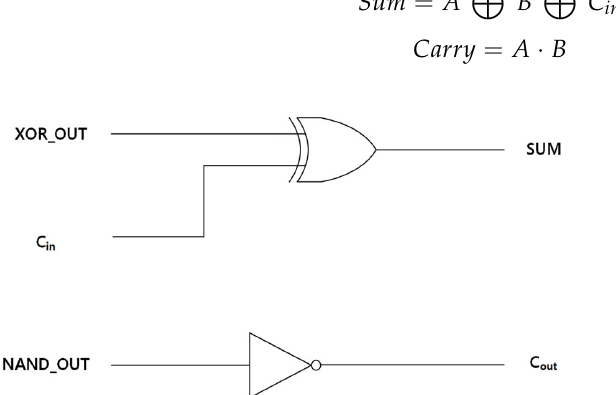
Figure 7. Additional gates for the proposed IMC approximate adder.